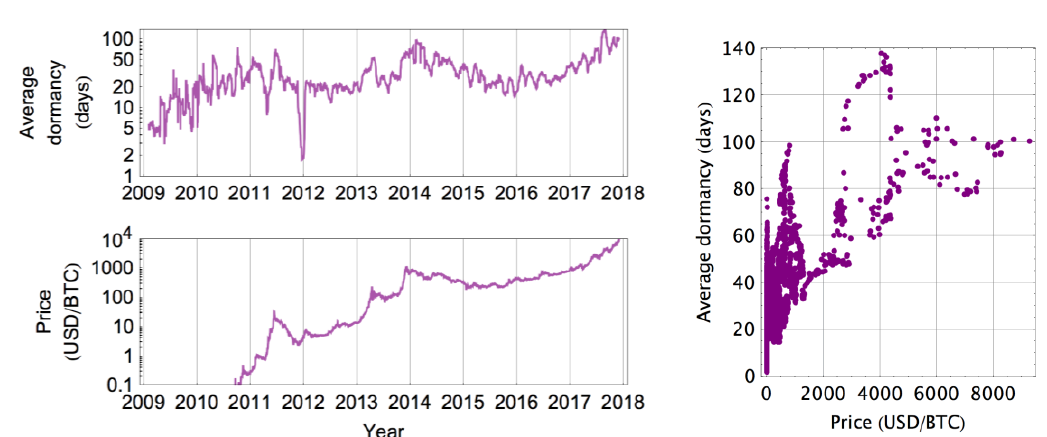
Fig. 3. 30-day average dormancy and Bitcoin exchange rate (green color) tracked over time (left), and versus each other